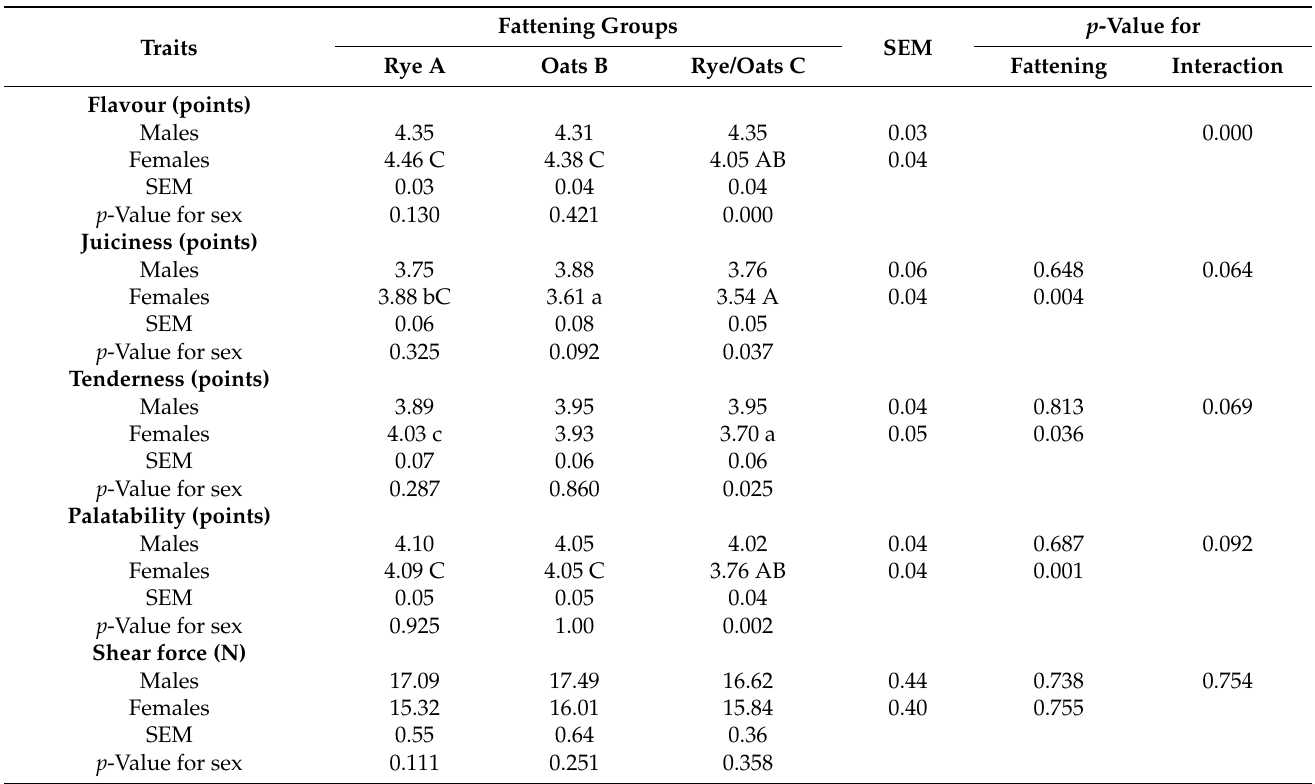
Table 8. Sensory evaluation results (points) and shear force measurements of cooked